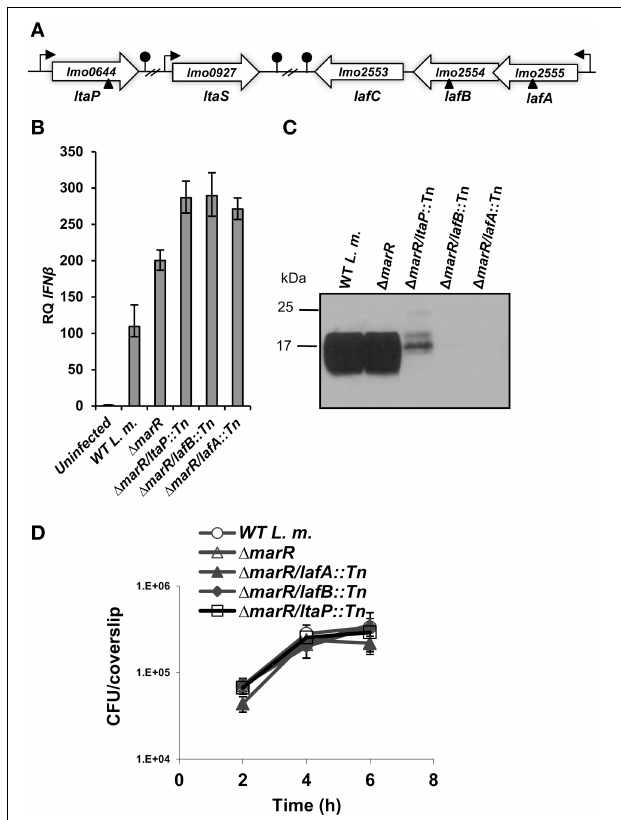
FIGURE 1 | L. monocytogenes LTA mutants trigger enhanced IFN- β response. (A) Schematic representation of the LTA biosynthesis genes in the L. monocytogenes 10403S genome. Transposon insertion sites are depicted by triangles. (B) RT-qPCR analysis of IFN- β transcription levels in BMD macrophage cells infected with WT L. monocytogenes , (cid:2) marR, and LTA transposon mutants in the (cid:2) marR background ( (cid:2) marR/ltaP::Tn , (cid:2) marR/lafB::Tn , and (cid:2) marR/lafA::Tn ) at 6h.p.i. Transcription levels are presented as relative quantity (RQ), relative to levels in uninfected cells. The data represent three biological repeats ( N = 3). Error bars indicate 95% confidence interval (as described in Materials and Methods). (C) Western blot analysis of cell wall-associated LTA in WT, (cid:2) marR and (cid:2) marR/ltaP::Tn, (cid:2) marR/lafB::Tn and (cid:2) marR/lafA::Tn transposon mutants grown in BHI medium at 37 ◦ C using polyglycerolphosphate-specific LTA antibody (Clone 55, Hycult biotechnology). Twenty microgram of total protein were loaded onto SDS-PAGE 15% gel, as described in the Materials and Methods. (D) Intracellular growth curves of WT L. monocytogenes , (cid:2) marR, and the LTA transposon mutants, in BMD macrophage cells. Representative growth curves are shown, one of three biological repeats ( N = 3). Error bars represent the standard deviation of a